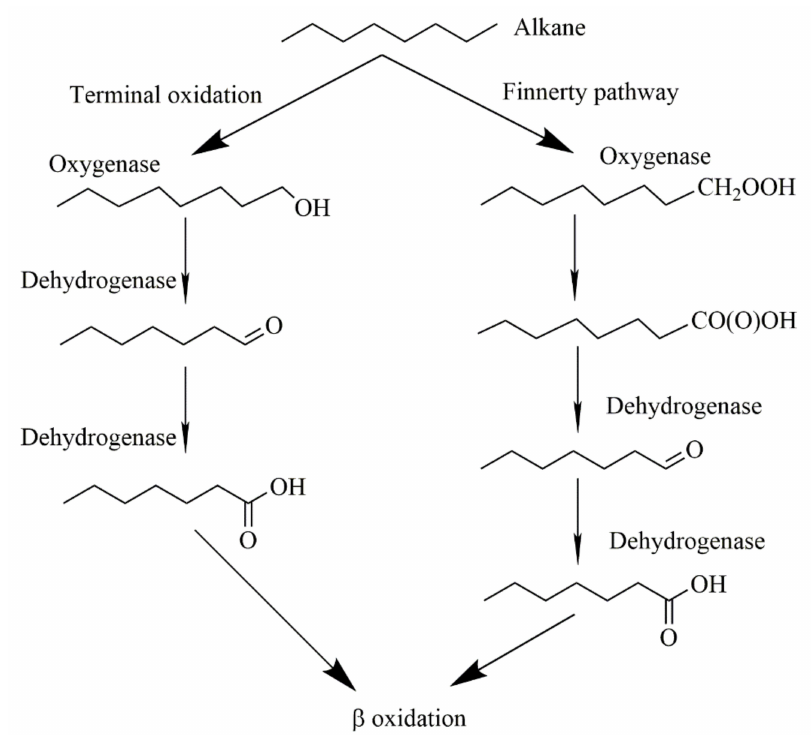
Figure 6. Two aerobic pathways of alkane degradation by Acinetobacter : Terminal oxidation and Finnerty